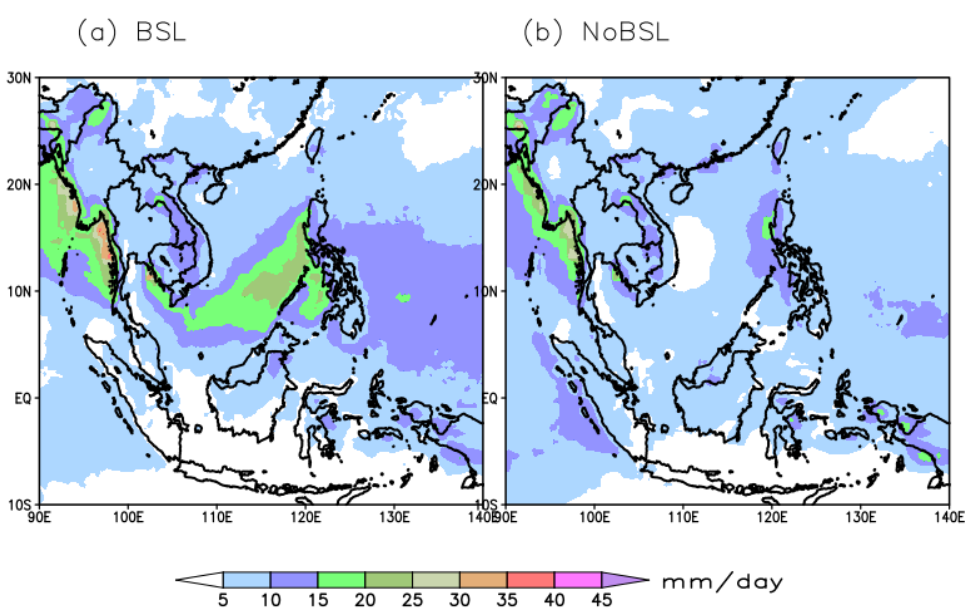
Figure 7. Composite daily rainfall charts of all collected ( a ) BSL days; and ( b ) non-BSL days from the year 1998 to 2018 (May–September). Green to red shaded area indicates heavier (intense) rainfall. The monthly composite of daily wind during all BSL days in May, June, July, August,